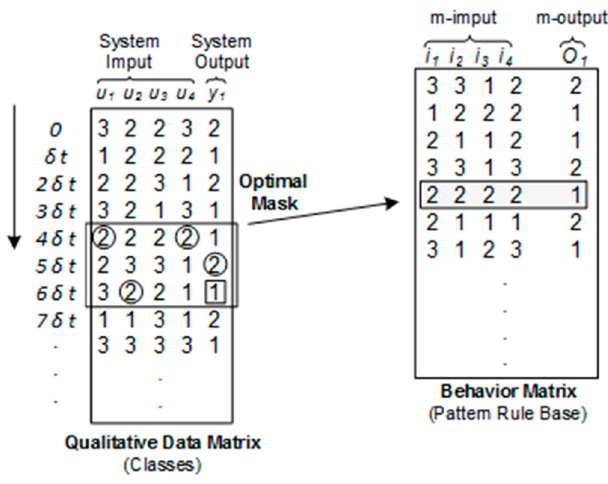
Figure 3. Derivation of FIR pattern rule base [23].